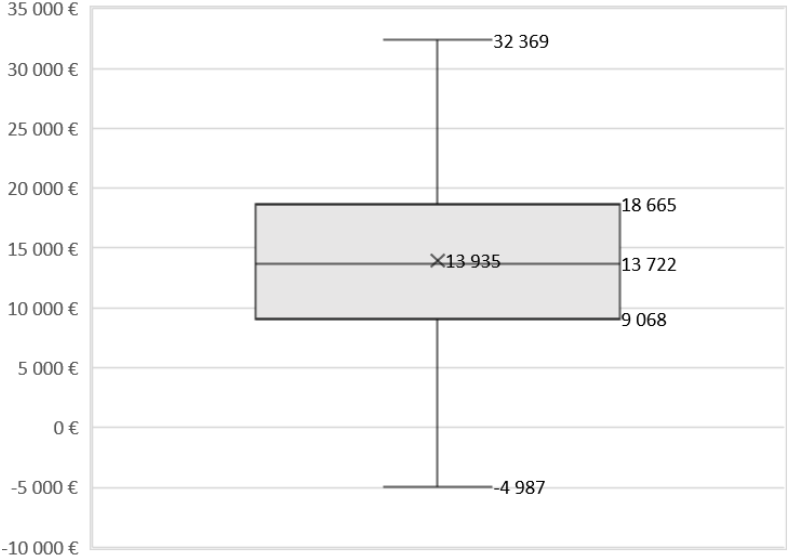
Figure 3. Boxplot of the annual budget impact (savings) according to the probabilistic sensitivity analysis.